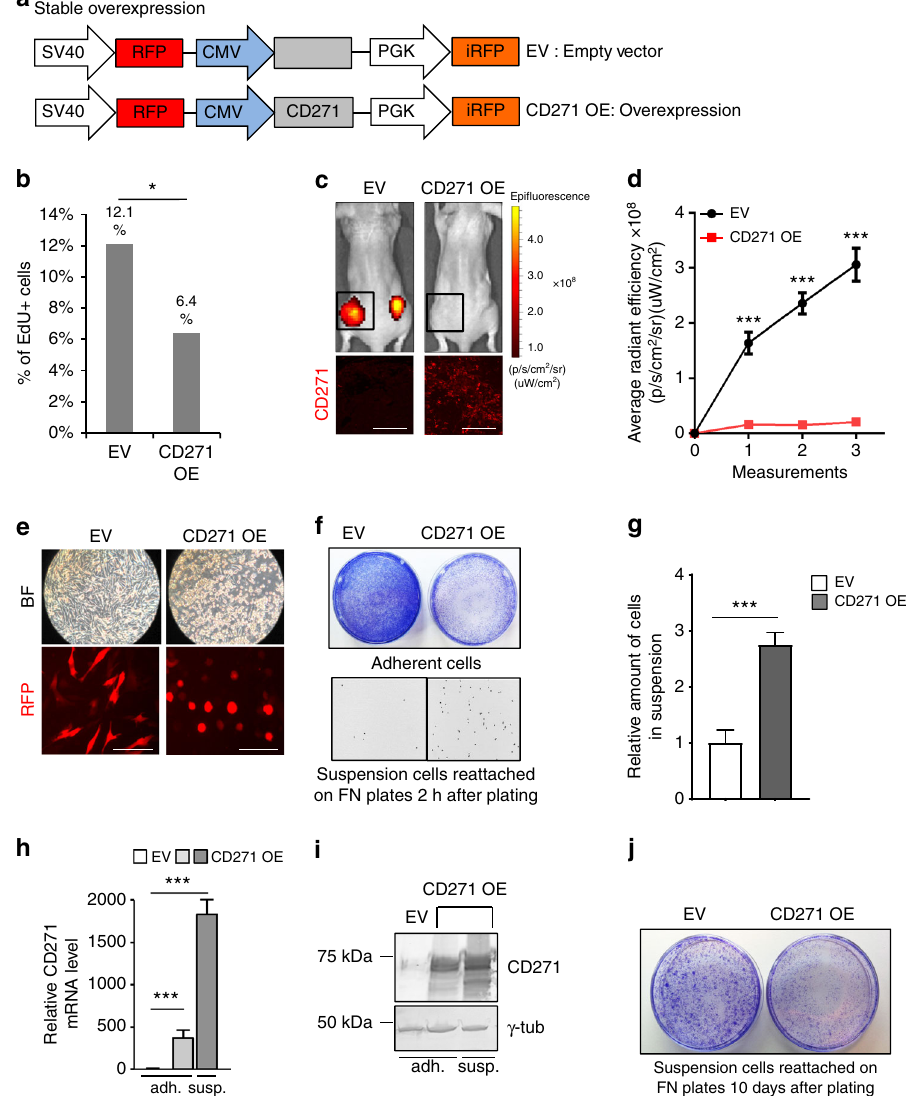
Fig. 3 CD271 overexpression impairs proliferation and adhesion. a Schematic representation of the lentiviral vector used to stably overexpress CD271 in melanoma cell lines. The viral backbone carries the Red Fluorescent Protein (RFP) and infrared fl uorescent protein (iRFP) reporters under the SV40 and PGK promoters respectively, as well as the CD271 overexpression cassette (CD271 OE) or an empty vector (EV) under the CMV promoter. b FACS analysis for EdU incorporation in cells 72 h after infection with EV or CD271 OE vectors ( n = 3; P value ≤ 0.05). c Upper panel: in vivo imaging of Nude mice injected with cells carrying the empty vector (EV) or the CD271 overexpressing construct (CD271 OE). The signal is from the infrared protein present in the lentiviral backbone. Lower panel: Immuno fl uorescence for CD271 protein in xenografts obtained by injection of melanoma cells containing the EV or the CD271 OE vector. Scale bars 100 µ m. d Quanti fi cation of the signal from iRFP by IVIS at different time points (four mice for a total of eight injections were analyzed for both control and CD271 overexpression; P value ≤ 0.001). Error bars indicate S.E.M. e Bright fi eld and fl uorescent micrographs of melanoma cells in culture 72 h after infection with the EV or CD271 OE vector. Scale bars 50 µ m. f Crystal violet staining of melanoma cells 72 h after infection with the EV or CD271 OE vector after washing (upper panel) and 2 h after suspension cells reattached on FN plates (lower panel visualized as inverted, black and white micrographs). g Quanti fi cation of the suspension cells re-attached on fi bronectin-coated plates. ( n = 3, P value ≤ 0.001) h qRT-PCR for CD271 levels in melanoma cells infected with EV or CD271 OE in the adherent and in the suspension fractions ( n = 3, P value ≤ 0.001). Error bars for g and h indicate S.D. i Western blot for CD271 levels in melanoma cells infected with EV or CD271 OE in the adherent and in the suspension fractions. j Crystal violet staining of suspension cells re-attached on fi bronectin-coated plates 10 days after seeding. All experiments done with cell line